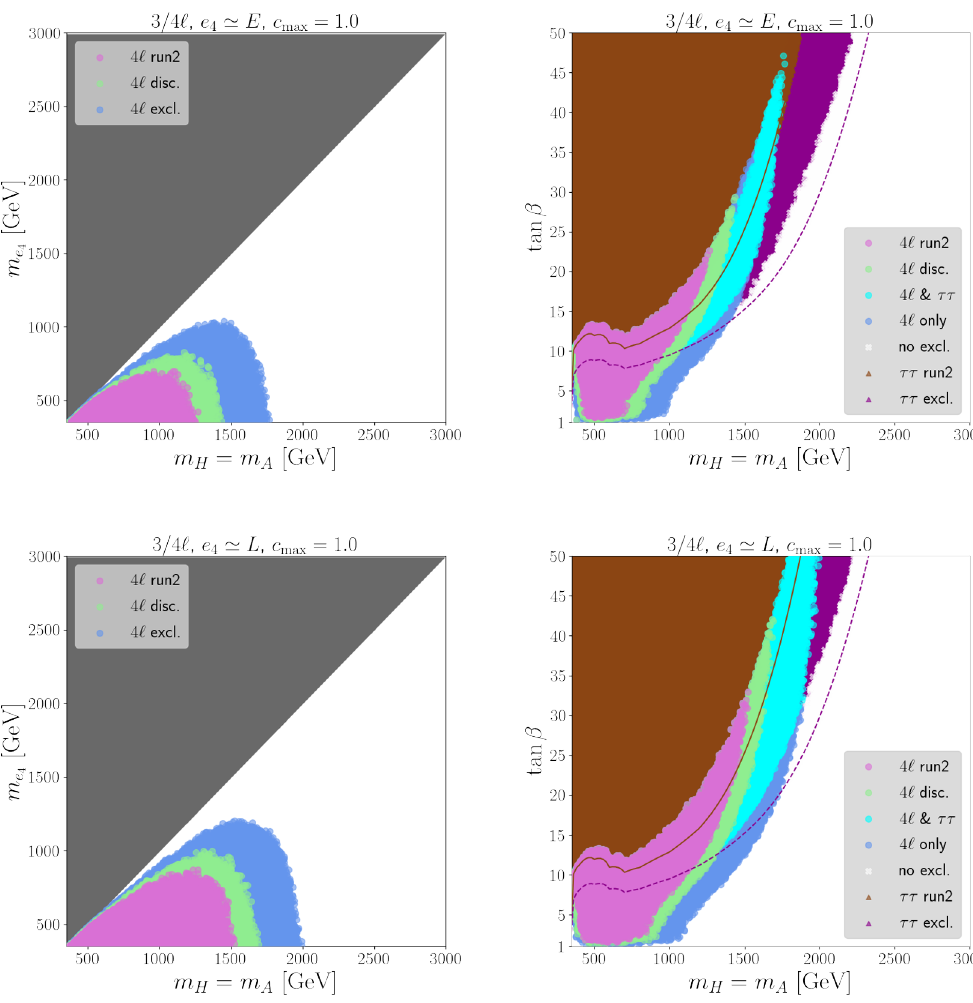
Figure 13 . Sensitivities of the 3 / 4 ‘ search to the light-E (light-L) scenario with c max = 1 in the upper (lower) panels. In the labels, “ 4 ‘ ” is a short for 3 / 4 ‘ search and the rest of the labels are the same as those in figure